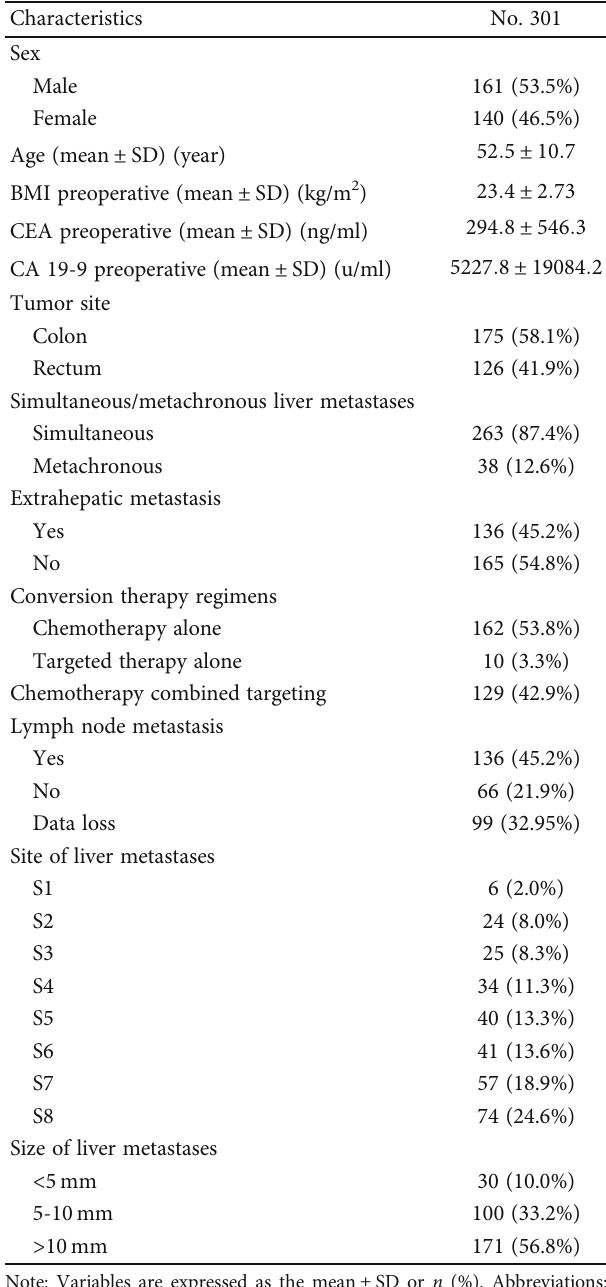
Table 1: Baseline characteristics of patients corresponding single